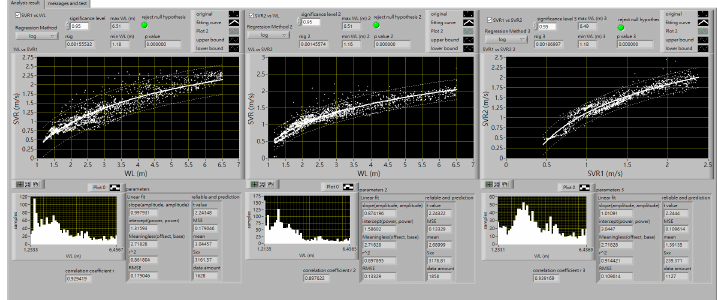
Figure 5. The interface of regression results with PI parameters.